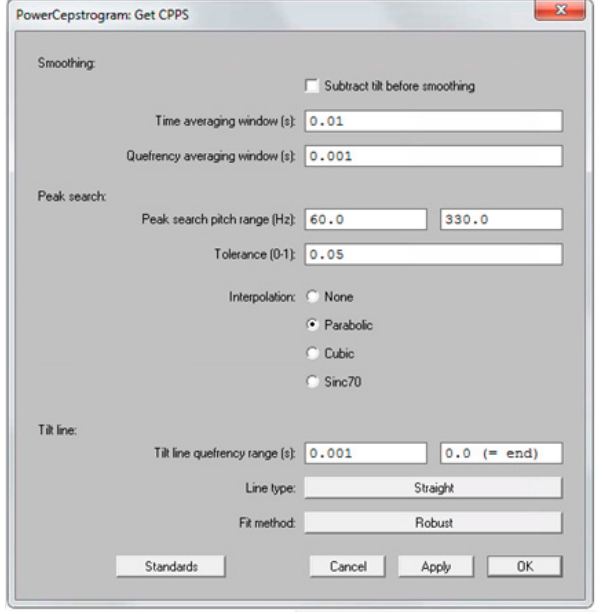
Figure 2. Printscreen with the arguments for the parameters to retrieve the smoothed cepstral peak prominence (CPPS) in the software Praat, for Windows computers (identical settings are used for Mac computers).